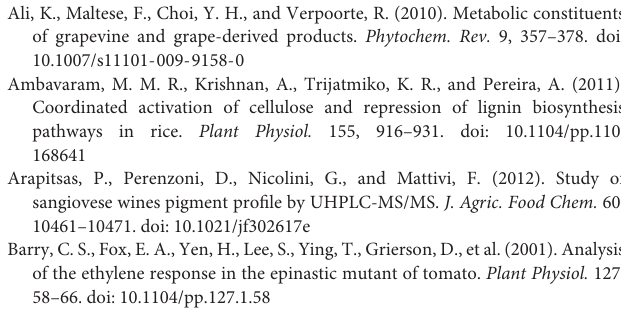
FIGURE S1 | Library size of each RNA-seq sample replicate. FIGURE S2 | Comparison of RNA-seq and real time RT-qPCR analysis. Expression profiles of VviERF045 VIT_04s0008g06000, RPT2 VIT_00s0665g00050, PIR VIT_00s1306g00010, NAC VIT_01s0026g02710, ERECTA VIT_04s0008g01970, SBP VIT_04s0210g00170, N-acetyltransferase VIT_05s0020g03680, HB1 VIT_12s0059g01190, SA VIT_14s0006g02170, YABBY VIT_15s0048g00550, Peroxidase VIT_16s0098g00820, HB1 VIT_18s0001g10160 . Lines represent expression levels (log Fold Change) by RNA-seq analyses in WT and L15, reported as means and standard errors of three independent biological replicates. Histograms represent the relative expression levels (logFC) to the expression of the WT, as assessed by real time RT-qPCR and reported as means and standard errors of three biological and two technical replicates for each plant line. Different letters show significant differences among samples with p < 0.05 and Tuckey’s significance test. In case of no significance no letters are reported in the figure. FIGURE S3 | GO term enrichment in selected DEGs. (A) Blast2GO Fisher’s enrichment test analysis for GOterms. Blue bars indicate Test Set (DEGs from L15 vs. WT comparison) while red line indicate the Reference Set (entire reference transcriptome). On the X -axis is reported the percentage of sequences for each GO category (B) Best 9 GOterms by comparing classic with weight method from Fisher’s test elaborated with TopGO (Alexa et al., 2006). FIGURE S4 | PCA score and loading plots of metabolites in the transgenic lines. Different color points represents different samples: black (L15), red (L19), green (L22), blue (L6), light blue (L7), pink (WT). Distribution of the average values in (A) all the analyzed metabolites, (B) phenolic compounds, (C) anthocyanins (D) lipids (E) chlorophylls (Ca and Cb coincide) and total carotenoids (Cxc). The most weighted loadings are represented in each plot. FIGURE S5 | Transcripts involved in Terpene biosynthesis. 4.2.3.46 alpha-farnesene synthase (AFS1) ( VIT_00s0361g00060, VIT_00s0392g00030, VIT_00s0392g00060 ), 1.14.99.7 ( VIT_00s0441g00020 ) squalene monoxygenase, 4.2.3.13 ( VIT_18s0001g04710 ) ( + )-delta-cadinene synthase, 4.2.3.75 (-)-germacrene D synthase ( VIT_18s0001g04990, VIT_18s0001g05240 ), 4.2.3.119 ( VIT_08s0007g06860 ) pinene synthase, 1.14.-.- CYP82C4 ( VIT_18s0001g11480 ), 1.3.3.9 CYP72A1 secologanin synthase ( VIT_19s0135g00150 ), 1.14.13.72 C-4 sterol methyl oxidase ( VIT_00s2125g00010 ), CYP724B1 ( VIT_14s0066g00170 ), CYP90B1 Steroid 22-alpha-hydroxylase ( VIT_04s0023g01630, VIT_04s0023g01640, VIT_12s0057g01460 ). Green color means down-regulated gene, red color means up-regulated gene. FIGURE S6 | Transcripts involved in alpha-linolenic metabolism. 1.13.11.12 LOX1 ( VIT_06s0004g01470 ) lipoxygenase 1, 21.1.141 Jasmonate O -methyltransferase (VIT_14s0006g02170) , MJAE MeJA esterase (VIT_00s0253g00090). Red color means up-regulated